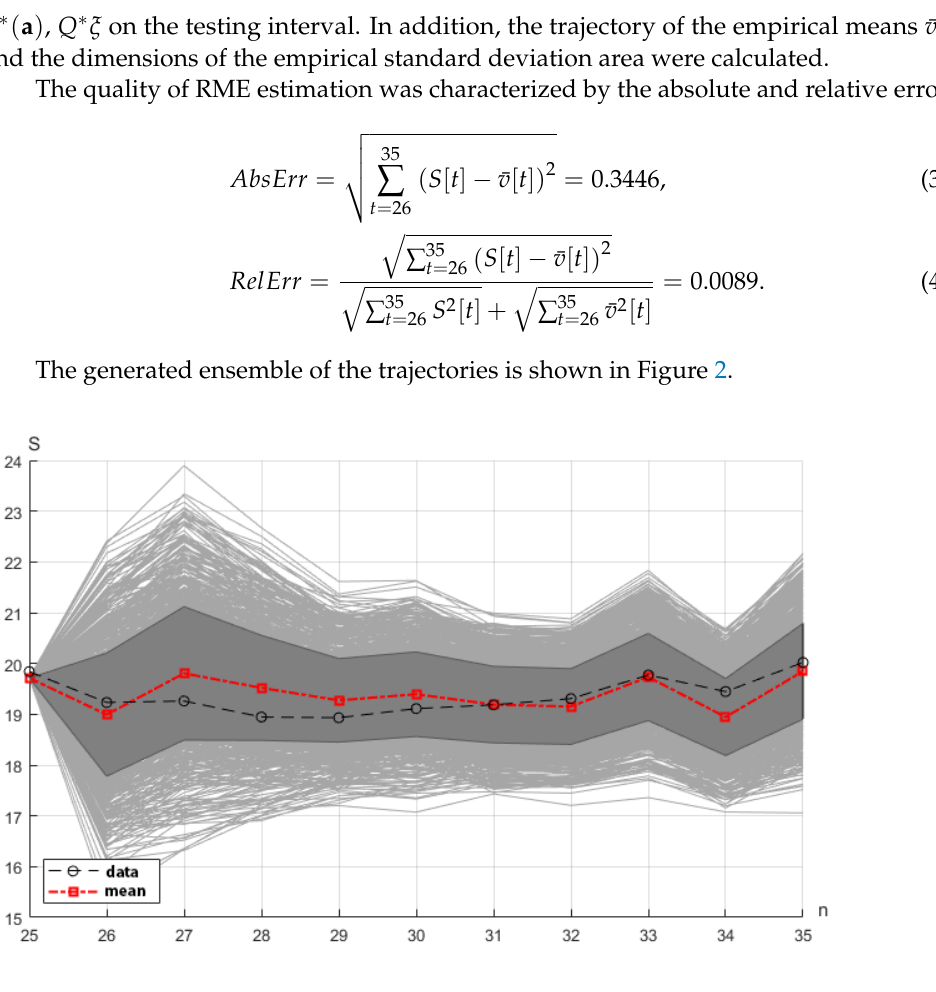
Figure 2. Ensemble of the trajectories (gray domain), the standard deviation area (dark gray domain), the empirical mean trajectory, and the lake area